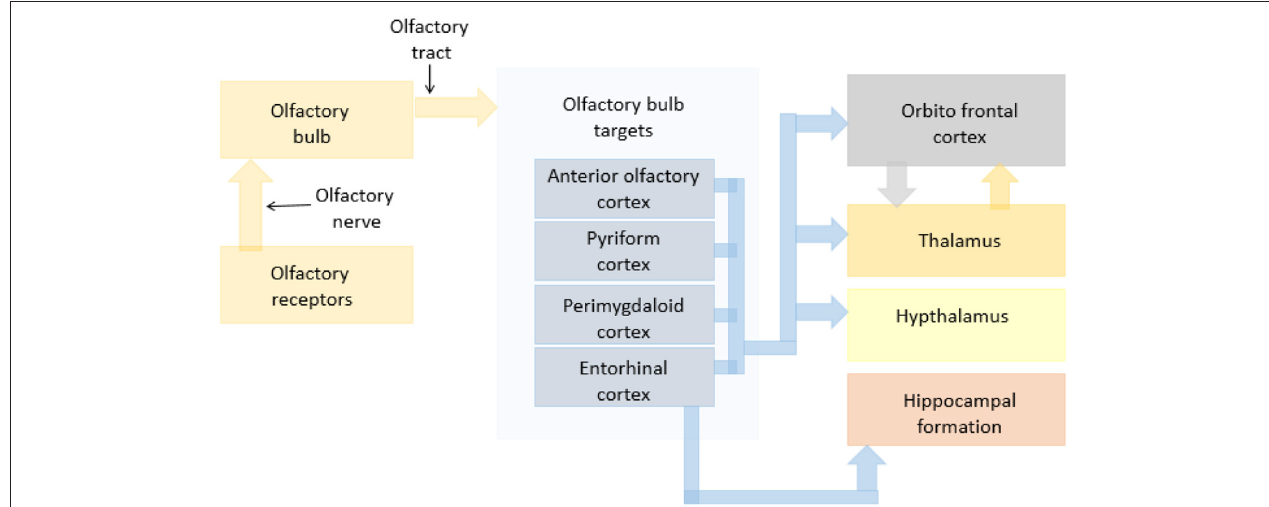
FIGURE 1 | A schematic flowchart indicating olfactory pathways in